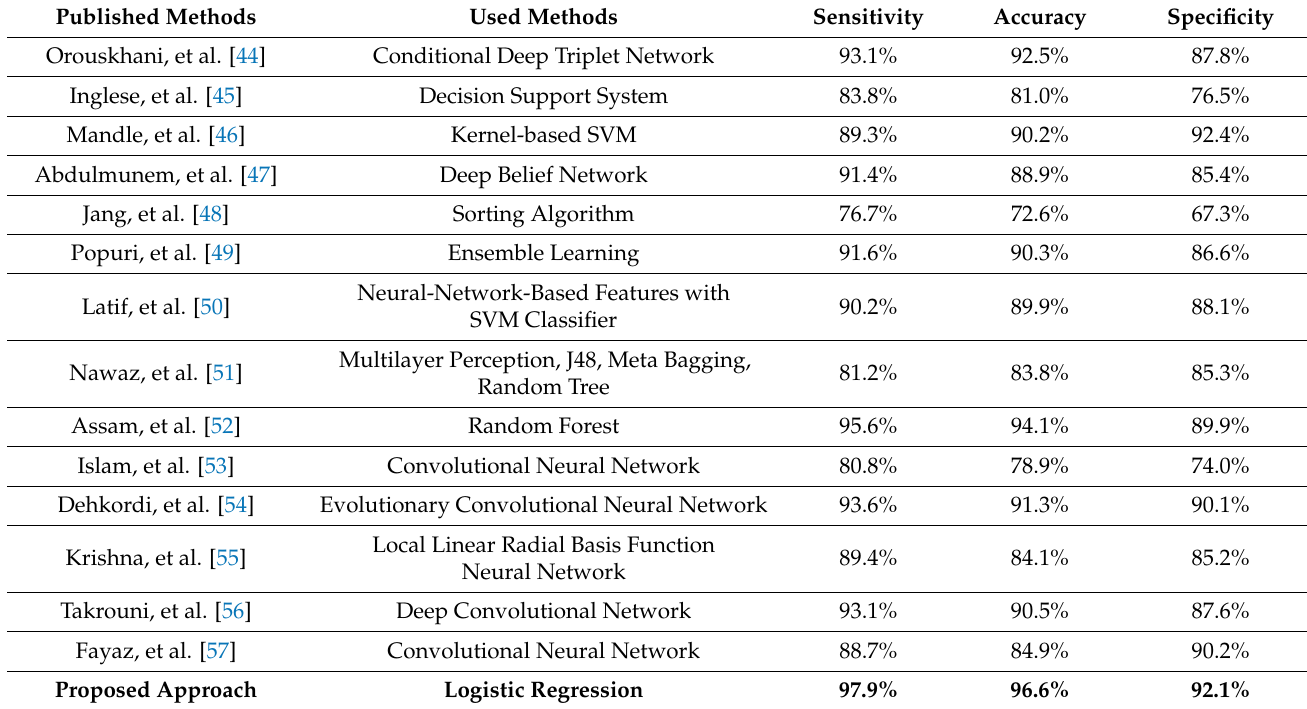
Table 11. Performance comparison of the state-of-the-art methods and the proposed approach using sensitivity, accuracy, and specificity on brain MRI dataset (Number of utilized images 595 (where, normal = 115, and abnormal =